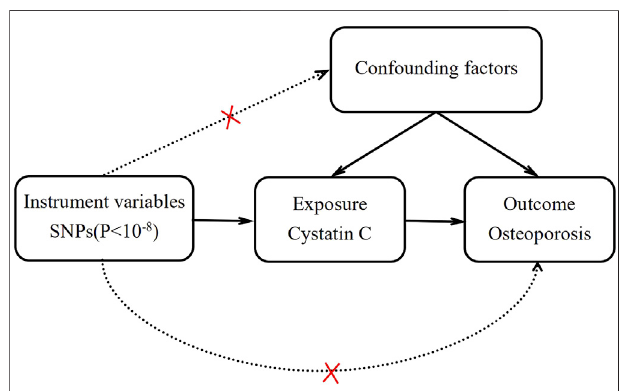
FIGURE 1 | The illustrative diagram of two-sample Mendelian randomization